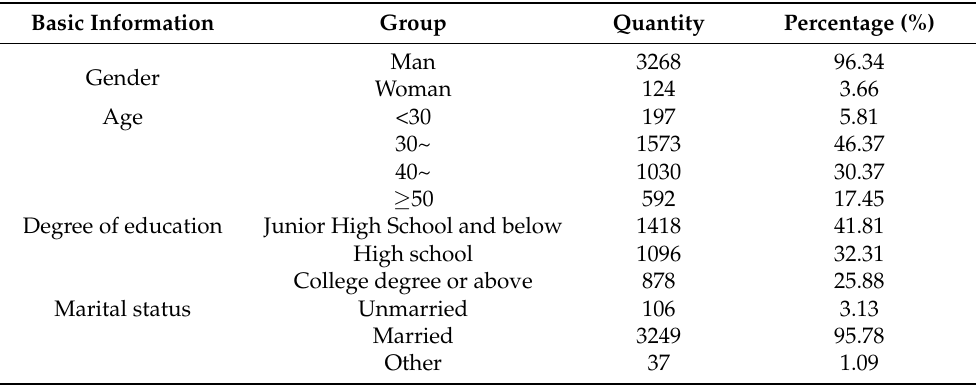
Table 1. Basic information of coal